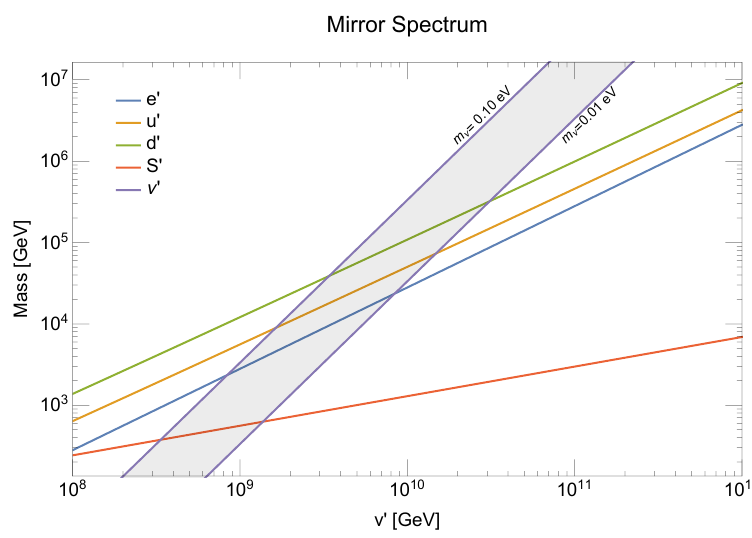
Figure 1 . Mass spectrum of key mirror particles. The purple band shows the range of mirror neutrino masses for SM neutrino masses betwen 0 : 01{0 : 10